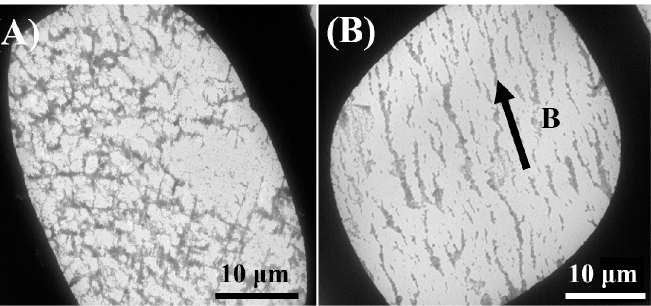
Figure 9. TEM images of the sample ( A ) without the magnetic field and ( B ) with the magnetic field. (The B shows the direction of the magnetic field).